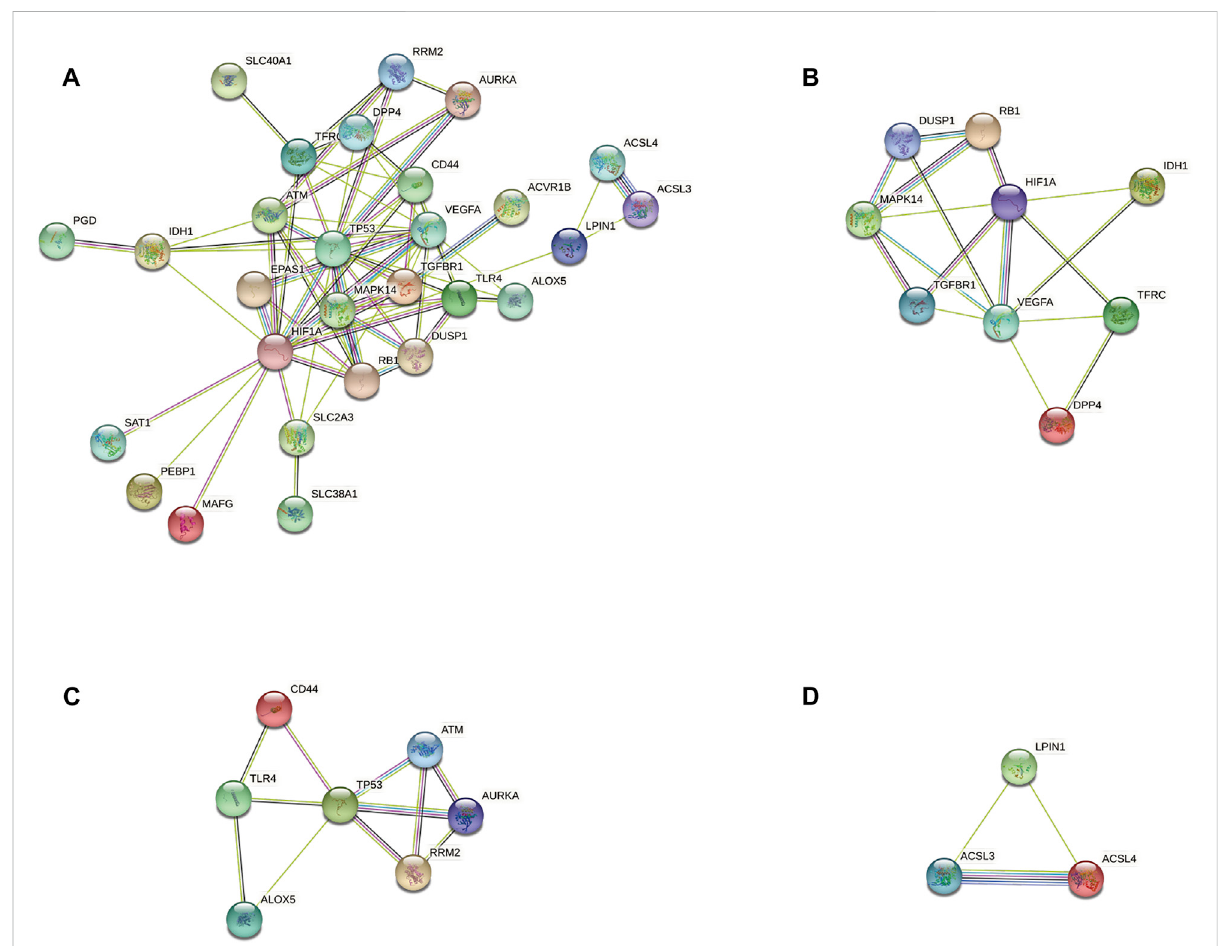
FIGURE 4 Protein – protein interaction network analyses of ferroptosis-related differentially expressed genes (DEGs). (A) PPI network of ferroptosis- related DEGs. (B) Cluster 1. (C) Cluster 2. (D) Cluster 3.